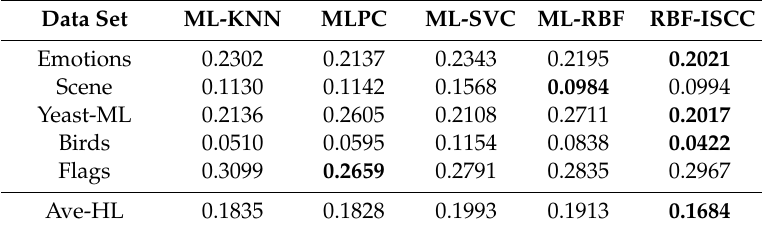
Table 10. Testing Hamming loss (HL) obtained for multi-label data sets.